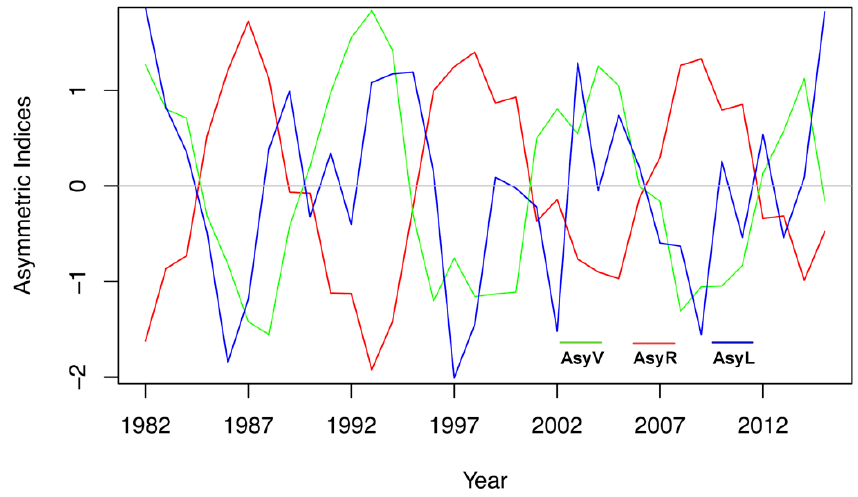
Figure 3. Interannual variations in vegetation growth asymmetries for the entire Northeast China (NEC). For better graphical presentation, raw annual time series were normalized.